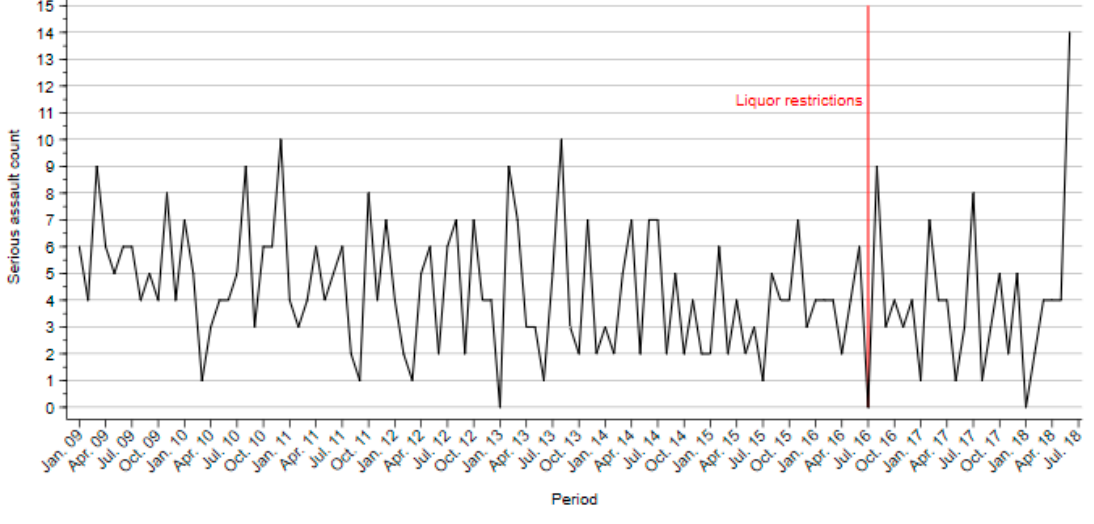
Figure 1. Serious assaults in safe night precincts with venues only affected by liquor restrictions during high-alcohol hours .